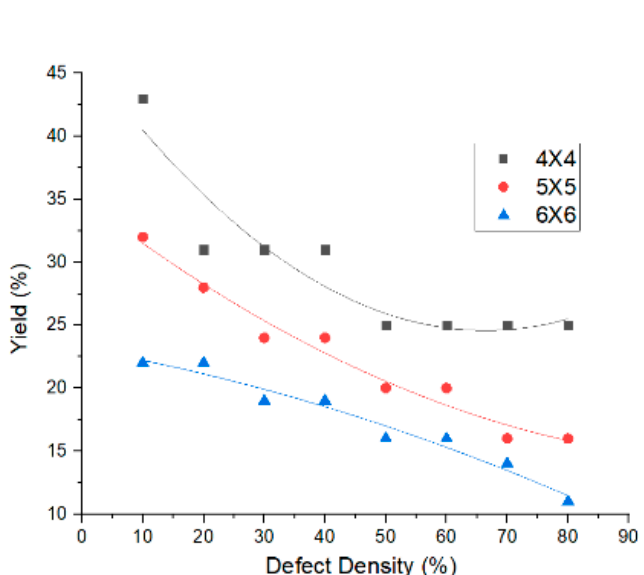
Figure 6. Defect density vs. yield plot for three different crossbar sizes.